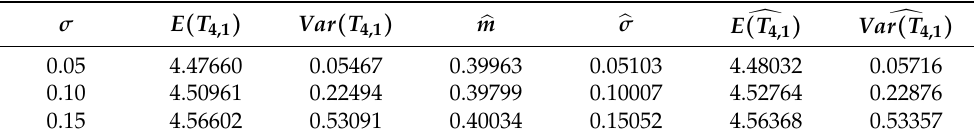
Table 2. Estimated values of m and σ , theoretical and estimated values for the mean and variance of the first-passage time (f.p.t.) variable T 4,1